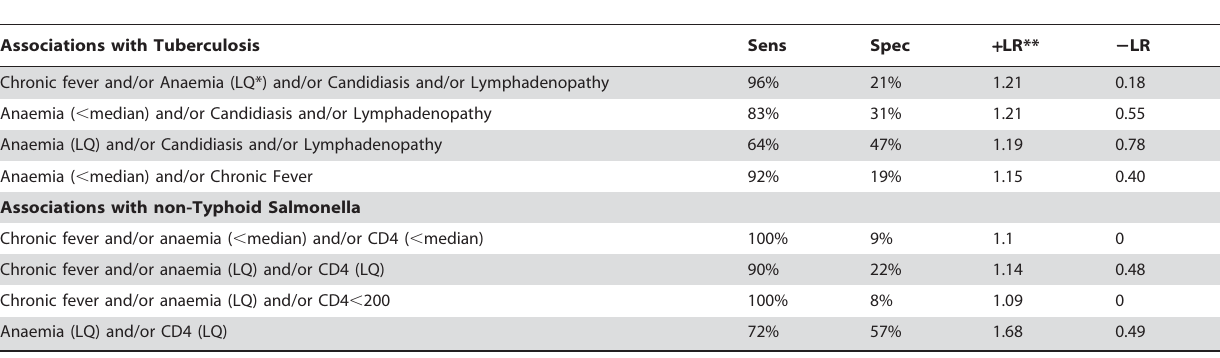
Table 4. Sensitivity & Specificity of Associations with